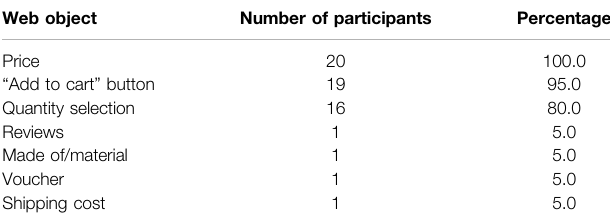
TABLE 6 | Web objects for inclusion in “ buy box ”